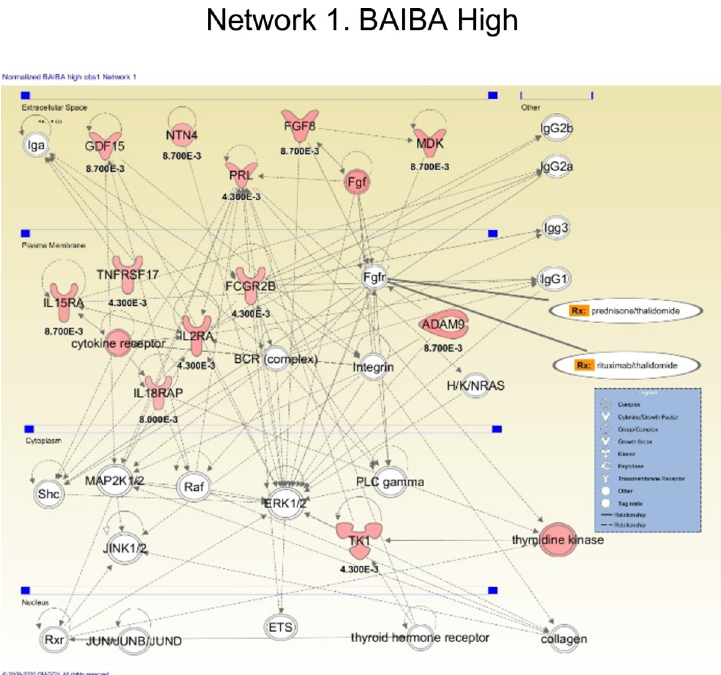
Fig 2. Ingenuity Pathway Analysis of BAIBA-responsive biomarkers identifies modulation of inflammatory pathways. The top IPA network identified with high dose BAIBA treatment data is shown.